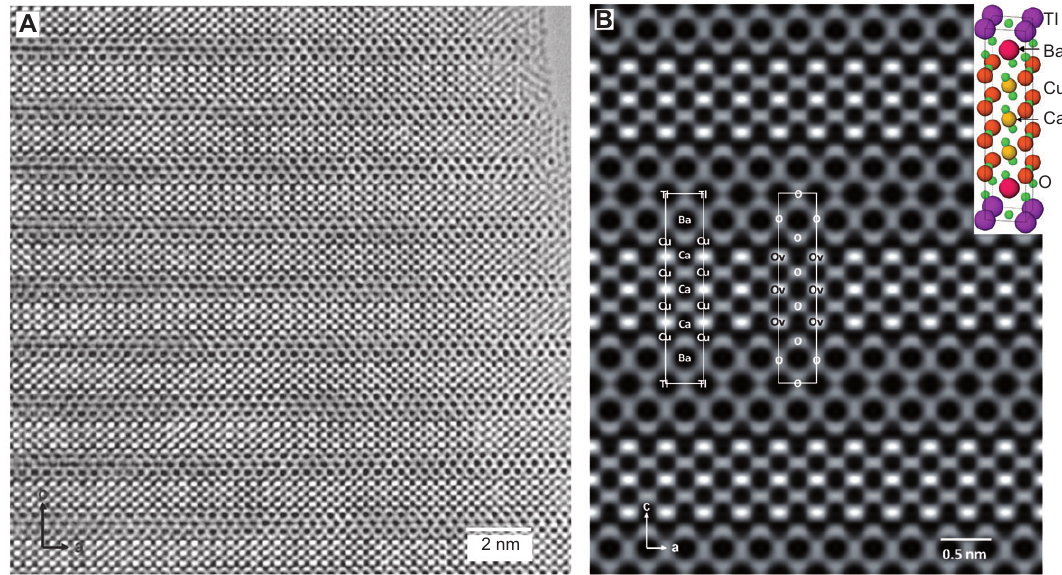
Figure 1 (A) HREM image of TlBa image processing of (A), together with a structure model of TlBa